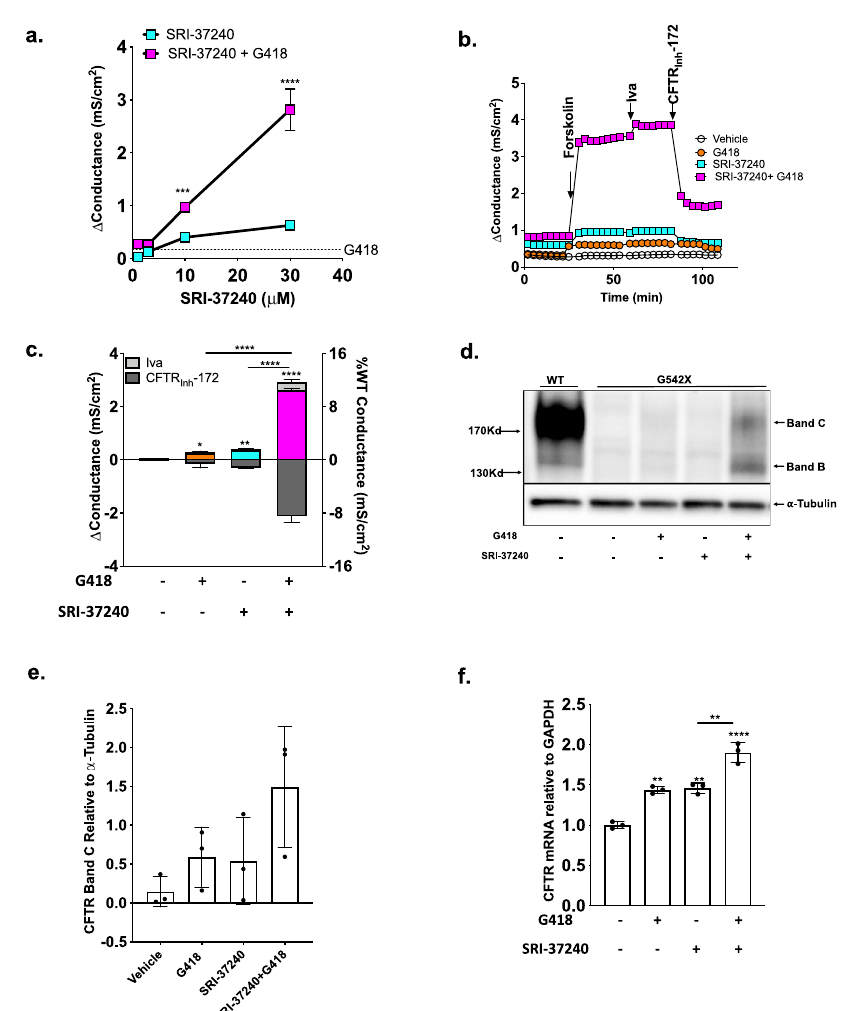
Fig. 2 CFTR expression and function is enhanced after combination treatment with SRI-37240 and aminoglycosides in FRT cells stably transduced with human CFTR -G542X cDNA. FRT monolayers were treated with SRI-37240 (10 µ M unless indicated otherwise) + / − G418 (100 µ g/mL) for 48 h on a liquid – liquid interface. a Forskolin-induced CFTR conductance after treatment with SRI-37240 at 1, 3, 10, and 30 µ M concentrations alone (blue squares) and in combination with G418 (purple squares) ( n = 4, data are statistically analyzed using Two-way ANOVA followed by Sidak ’ s post hoc test, p = 0.0006 (SRI-37240 vs SRI-37240 (10 uM) + G418), p < 0.0001 (SRI-37240 vs SRI-37240 (30 uM) + G418). b Representative conductance tracings after treatment with SRI-37240 + / − G418. c Corresponding summary of conductance measurements of SRI-37240 + / − G418 after forskolin stimulation (represented by corresponding colors as in raw tracings in Fig. 2b) and ivacaftor (iva) (light gray) induced CFTR conductance and CFTR Inh -172 (dark gray) mediated inhibition; also expressed as % of wild-type CFTR conductance in isogenic FRT cells (i.e., 25 mS/cm 2 ) ( n = 3, data are expressed as mean ± S.D. and statistically analyzed using repeated measures one-way ANOVA followed by Tukey ’ s post hoc test). **** p < 0.0001 (G418 vs SRI-37240 + G418), **** p < 0.0001 (SRI-37240 vs SRI-37240 + / − G418). d Representative western blot showing increased CFTR band C (fully mature) and band B (core glycosylated) after combination treatment with SRI-37240 + / − G418. Total protein loaded: WT = 10 µ g and G542X = 30 µ g). e Densitometric quanti fi cation of full-length CFTR Band C (mature form) relative to α -tubulin from FRT cells expressing wild-type or G542X CFTR cDNAs after treatments with SRI-37240 and G418 (alone or in combination). f Steady-state CFTR transcript levels by real-time RT-PCR relative to GAPDH after treatment with SRI- 37240 + / − G418. Data is the representation of n = 3 monolayers per condition and 2 – 4 experimental repeats for each experiment ( n = 3, data are expressed as mean ± S.D. and statistically analyzed using ordinary one-way ANOVA followed by Tukey ’ s post hoc test, p = 0.0019 (Vehicle vs G418), p = 0.0014 (Vehicle vs SRI-37240), p < 0.0001 (Vehicle vs SRI-37240 + G418), p = 0.002 (SRI-37240 vs SRI-37240 + G418). For all panels, * p ≤ 0.05, ** p